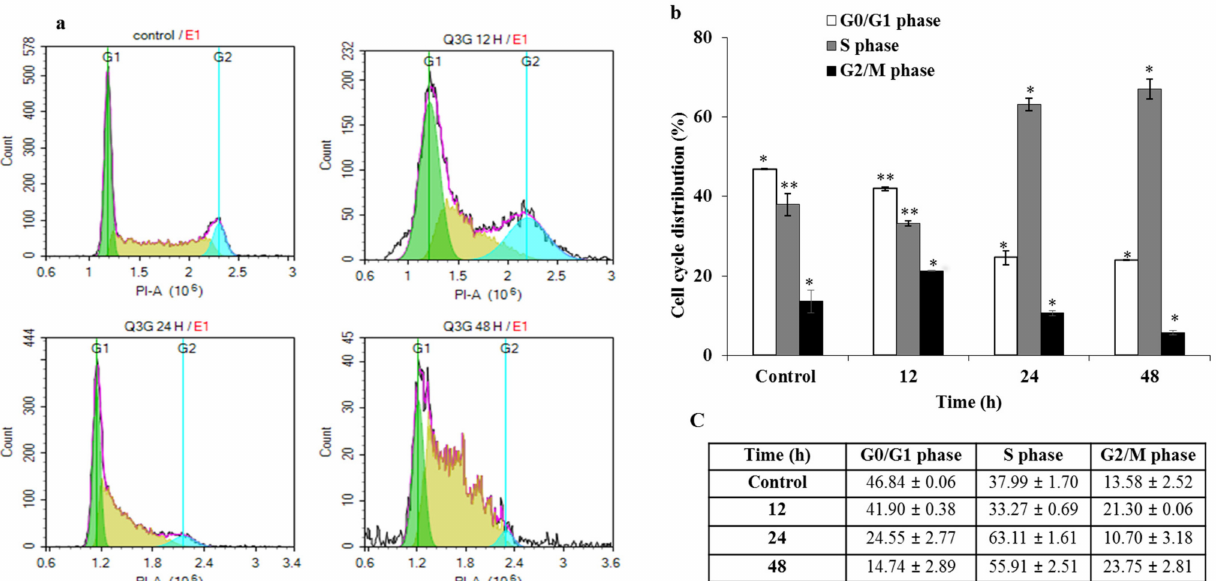
Figure 3. Hela cell cycle analysis with PI: ( a ): After treatment with 30 µ g of Q3G for 24 or 48 h, HELA cells were analyzed for cell cycle distribution with Novocyte flow cytometer. The representative plot shows cells in G 0 /G 1 phase (green), S phase (yellow), and G 2 /M phase (blue). Compared to normal DMSO treated cells (Control), Q3G treated cells were arrested at S phase and G 2 /M phase. ( b ): Graph shows the percentages of cells in G 0 /G, S and G 2 /M phase. ( c ): Data in the table are mean ± SD of two independent experiments in triplicate. * p < 0.05, ** p < 0.01 indicate the significant differences from the